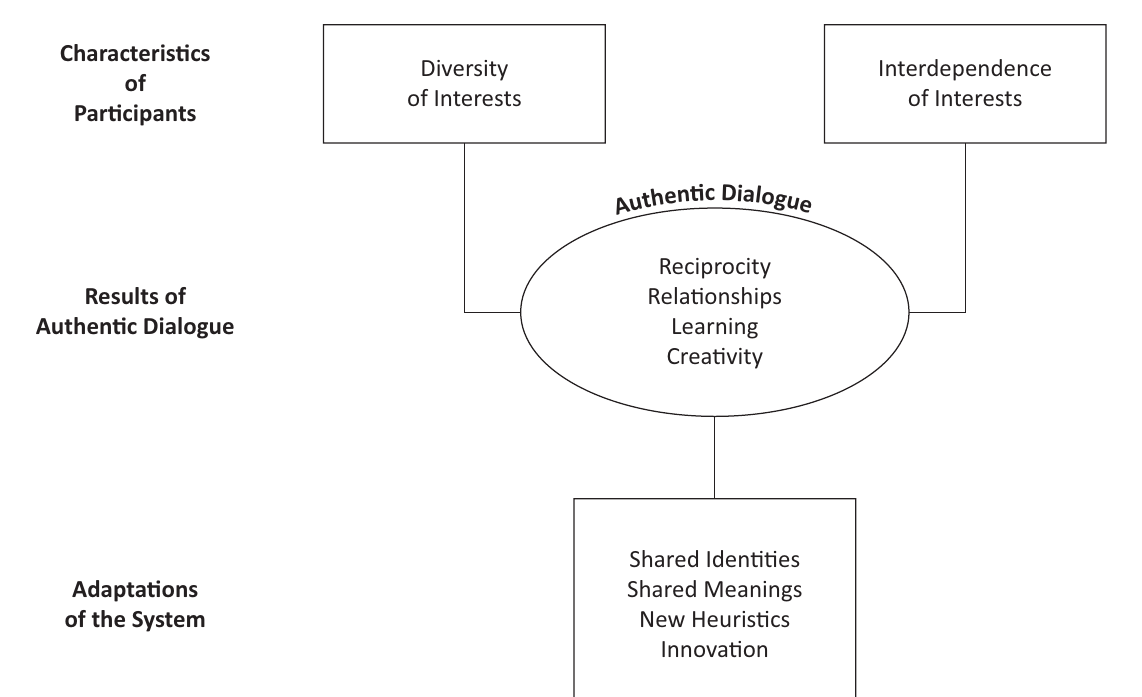
Figure 2. The integration of the diverse, interdependent interests through authentic dialogue as a way to achieve change in the policy system and urban environment (Innes & Booher, 2010, p.